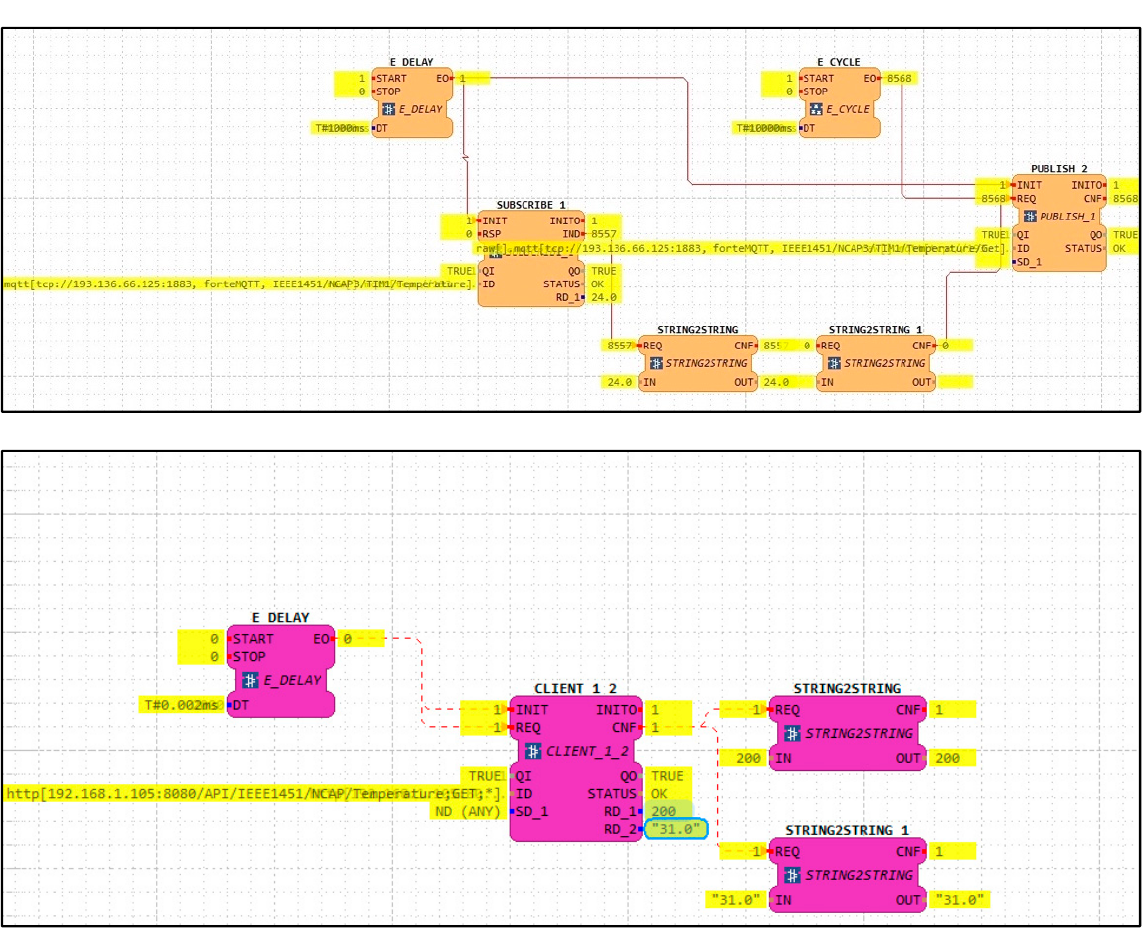
Figure 7. 4diac MQTT and HTTP FBs.